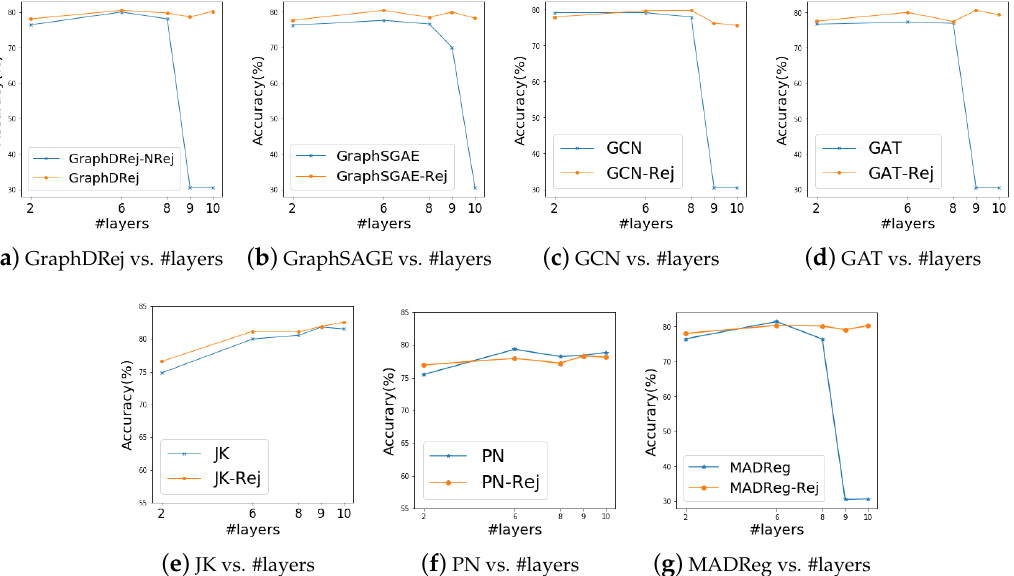
Figure 5. The results of GNNs combined with the rejection mechanism on Cora. “XX-Rej” refers to the model XX with the rejection mechanism, and GraphDRej-NRej refers to the version of GraphDRej without the rejection